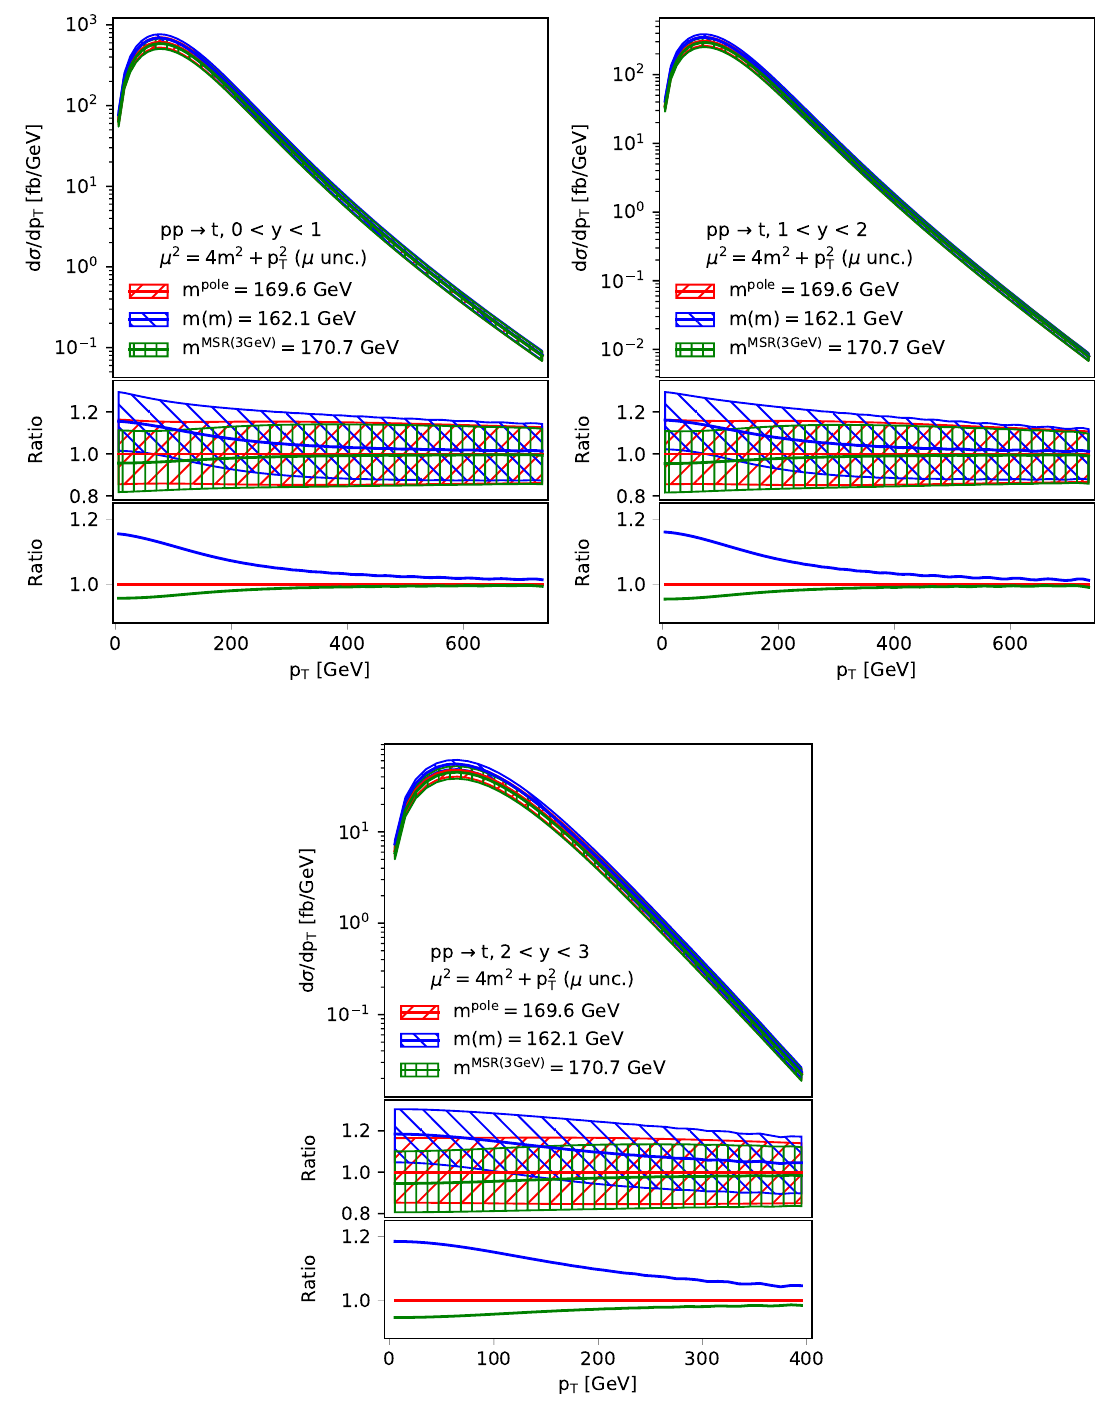
Figure 7 . Same as figure 6, but for the top-mass value m t ( m t ) = 162.1 GeV (converted to m MSR (3 GeV) = 170.7 GeV and m pole = 169.6 GeV), as extracted in the ABMP16 NLO t t